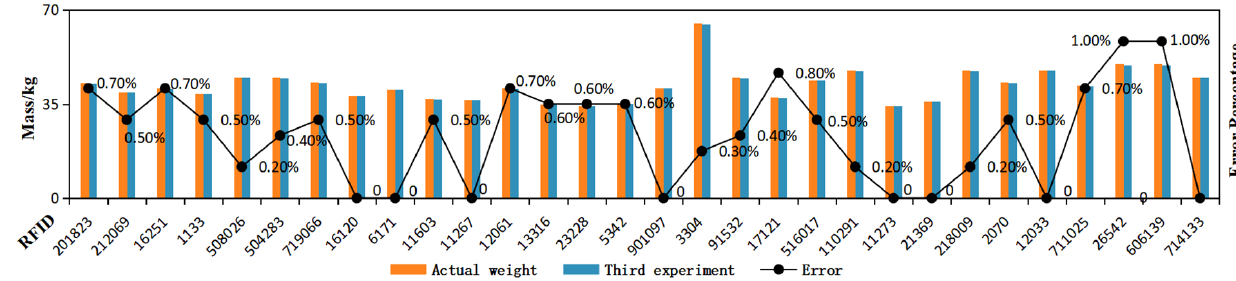
Figure 24. Data plot of the third experiment.